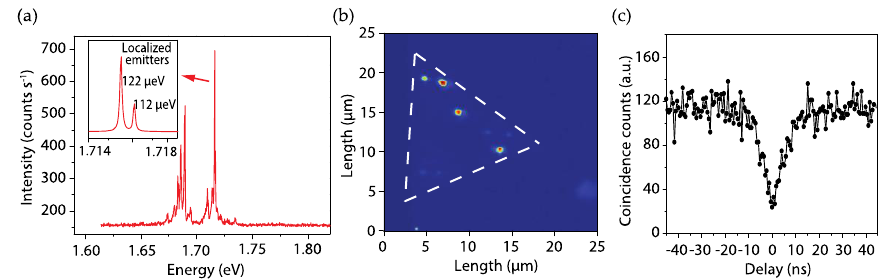
Figure 7. ( a ) Photoluminescence (PL) spectrum of localized emitters showing narrow emission lines. The inset shows a high-resolution spectrum of the brightest line in the main panel. ( b ) PL intensity map of the narrow emission lines centered around 1.719 eV. The dashed line indicates the monolayer. ( c ) Second order correlation measurement of the PL of a localized emitter showing photon antibunching. ( a – c ) reproduced with permission from [86], Copyright Nature Publishing Group, 2015.